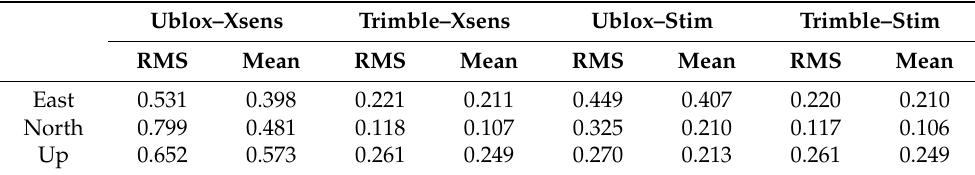
Table 3. RMS error and mean error (m) in east, north, and up directions—first field trial.